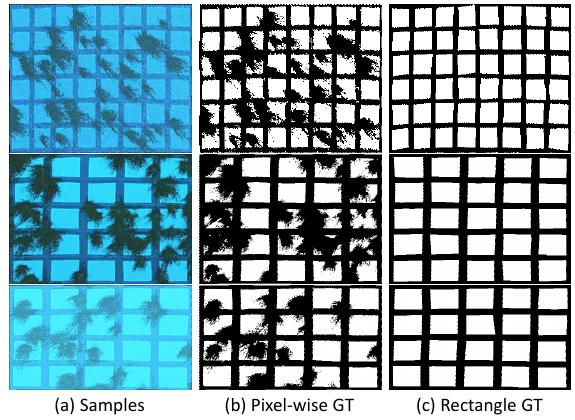
Figure 10. Samples generated from raw images. ( a ) samples; ( b ) pixel-wise ground-truth; and ( c ) rectangle